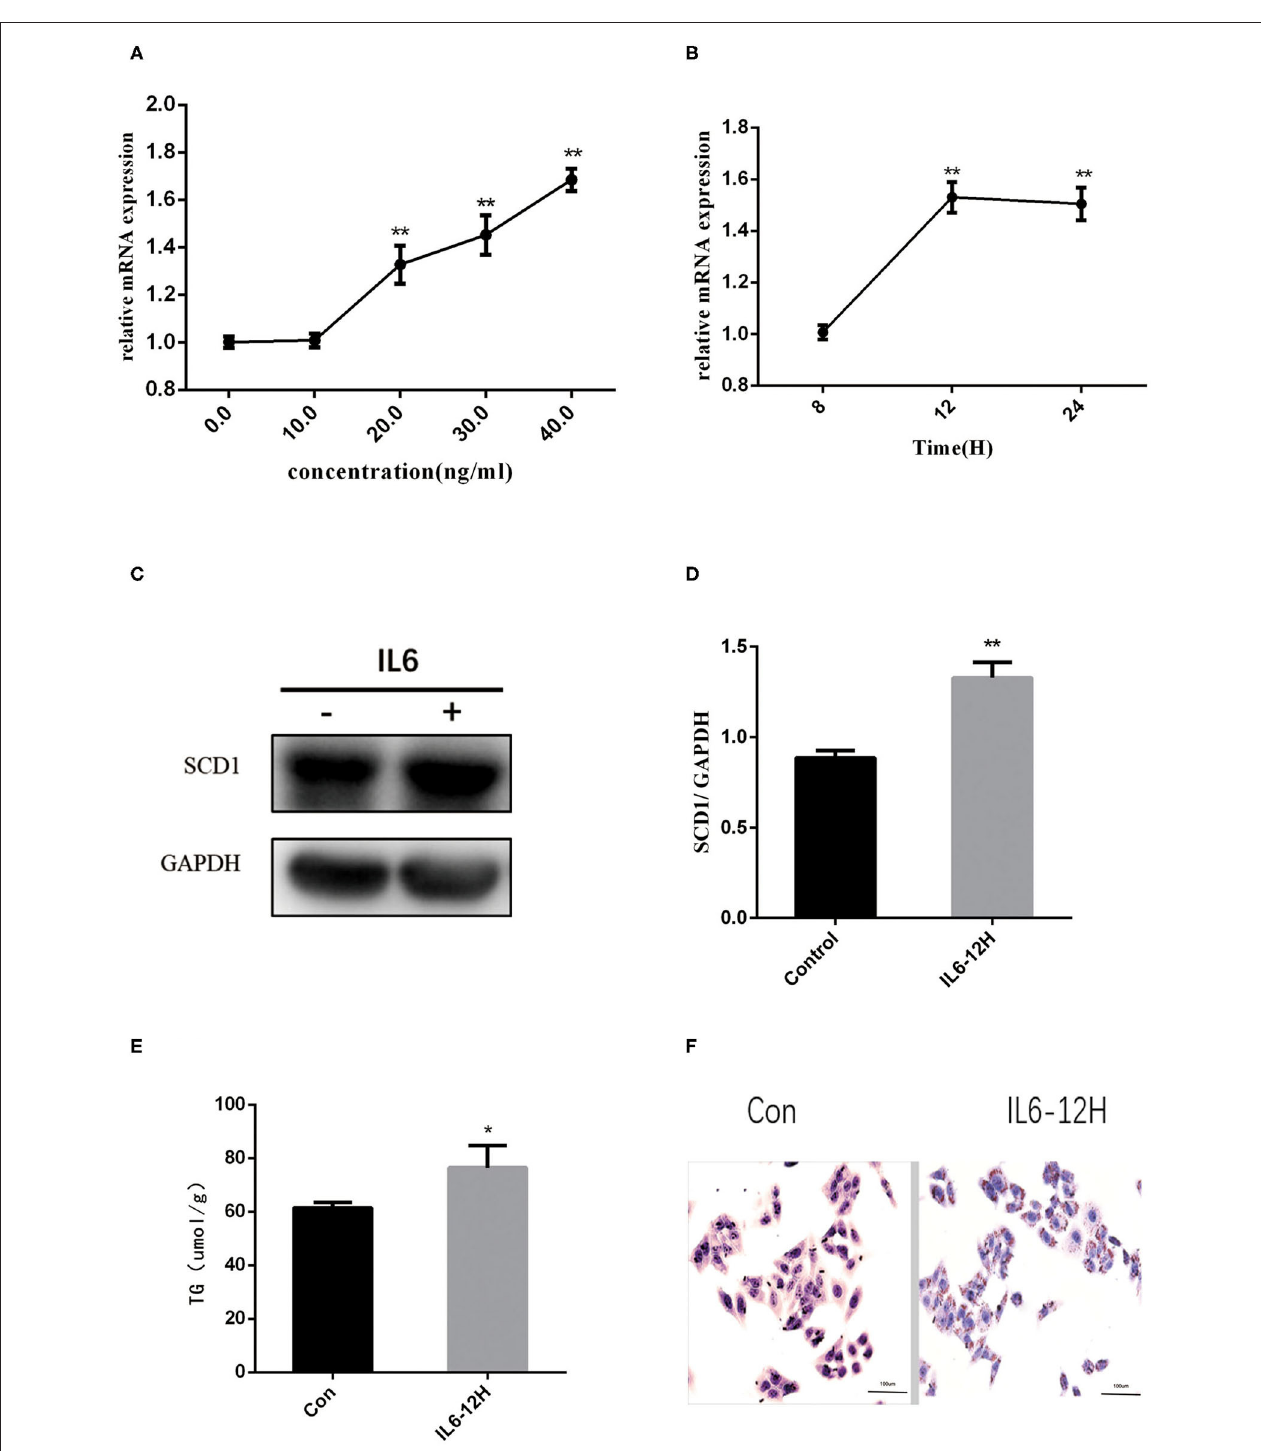
FIGURE 3 | Recombinant interleukin-6 (rIL6) treatment induces an increase in SCD1 expression and lipid metabolism in HepG2 cells. (A) Scd1 mRNA expression levels in HepG2 cells upon rIL6 treatment at different concentrations. (B) Scd1 mRNA expression levels in HepG2 cells upon rIL6 treatment at different time points. (C) SCD1 protein levels in HepG2 cells with the treatment of rIL6 at 40 ng/ µ l for 12h. (D) The relative protein levels of SCD1 in HepG2 cells with the treatment of rIL6 at 40 ng/ µ l for 12h. (E) TG levels in HepG2 cells with the treatment of rIL6 at 40 ng/ µ l for 12h. (F) Oil red O staining of HepG2 cells. a: Control group; b: HepG2 cells upon rIL6 treatment at 40 ng/ µ l for 12h. ** P < 0.01; * P < 0.05.